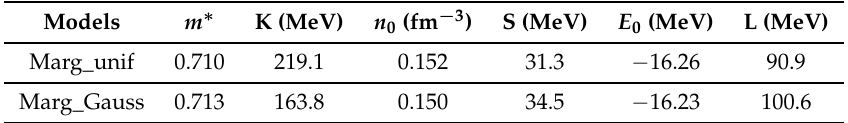
Table 2. Most probable empirical parameters of the joint posterior distribution for the two priors. We also report the values of the slope of the symmetry energy at saturation L